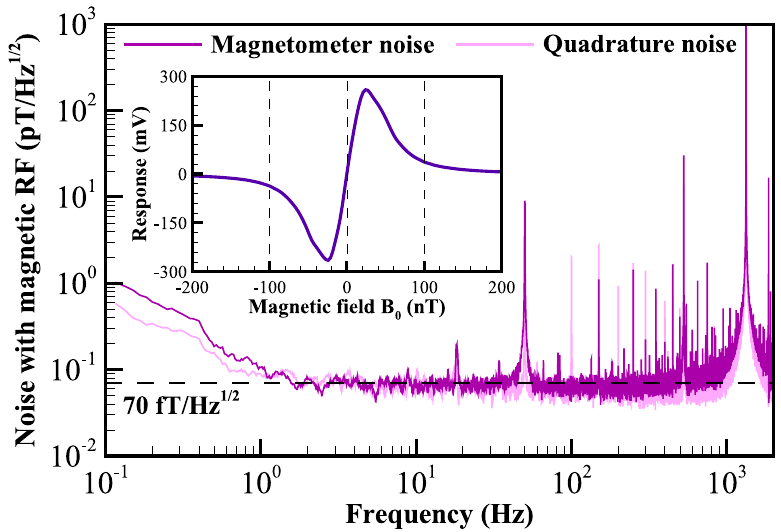
Figure 6. Spectral densities of the noise under the condition of using a magnetic RF field to induce parametric resonance. The sensitivity is approximately 70 fT/Hz 1/2 . The magnetometer noise floor is close to that of magnetic-insensitive quadrature-demodulated noise. The inset shows the magnetic response of the demodulated signal in the magnetic RF